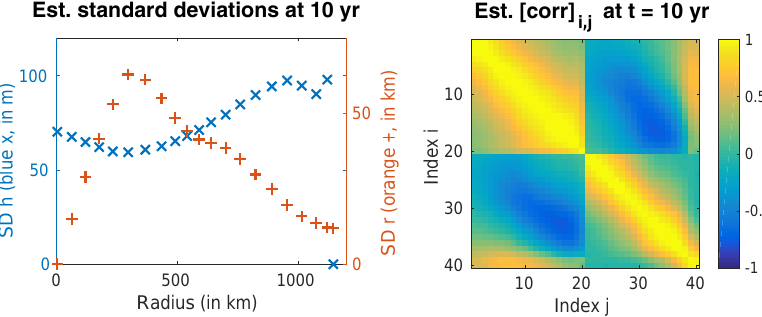
Figure 17. Standard deviations and correlation matrix Corr estimated from the analysis ensemble at time t = 10 years in the advanced configuration where we observe surface ice velocity and the position of the margin. The matrix Corr has the same structure as B defined by Eq. (28). Both standard deviations and cross-correlation structures are different from those shown in Fig. 14.